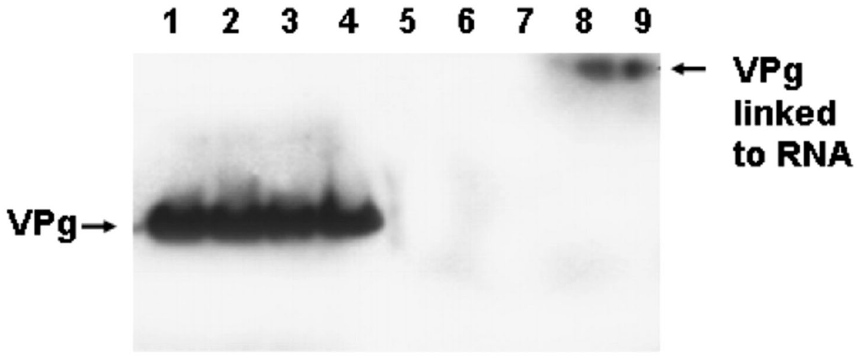
Figure 4. CVB3/TD viruses have VPg covalently attached to genomic RNA. Viral RNA was purified from stocks of the CVB3/28, TD8, and TD50 viruses (10 5 TCID 50 units) and analyzed by Western blotting. Blots were probed with an antibody to PV1 VPg (N10). Lane 1 (PV1 Sabin), lane 2, 5 (CVB3/28), lane 3, 6, 8 (CVB3/TD8), lane 4, 7, 9 (CVB3/TD50). Lanes 1–4, RNA was treated with RNase A/T 1 ; lanes 5–7, RNA was treated with RNase A/T 1 and proteinase K; lanes 8 and 9, RNA was untreated. Adapted with permission from [50] 2005, American Society for Microbiology.